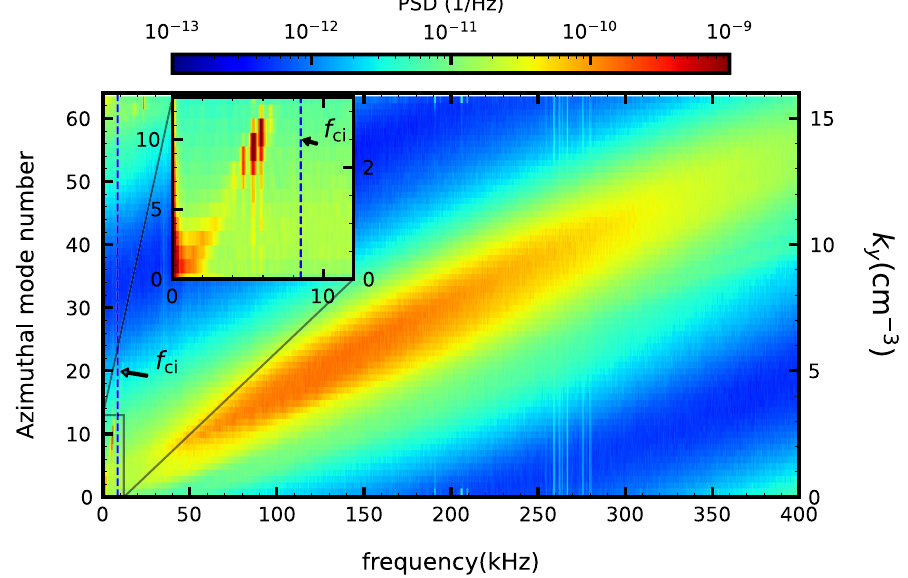
Figure 3. A contour plot of two-dimensional frequency and wavenumber power spectrum density of the normalized ion saturation current observed in Fig. 2. A subfigure in this graphshows an enlarged view of the low-frequency range. Dashed lines indicate the ion cyclotron frequency f ci . The left and right vertical axes denote the azimuthal mode number m and the corresponding wavenumber k θ ,